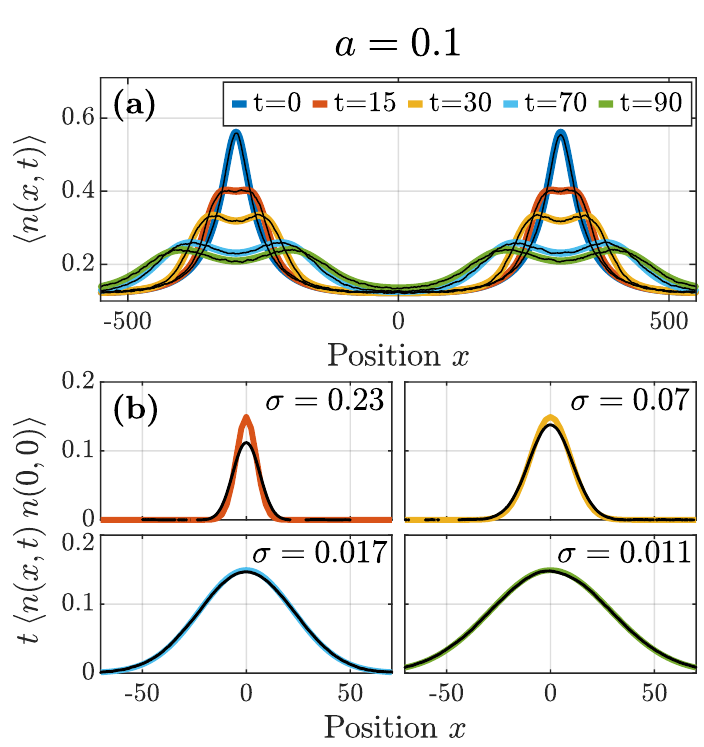
Figure 5: Release of a double density bump in the hard-rod model calculated using GHD (colored lines) and Monte-Carlo (black lines). Parameters of the Monte-Carlo simulations are specified in the text. (a) Comparison of the evolution of the linear density. (b) Comparison of two-point correlation t 〈 n ( x , t ) n ( 0,0 ) 〉 multiplied by time t and the relative distance between the two approaches, σ